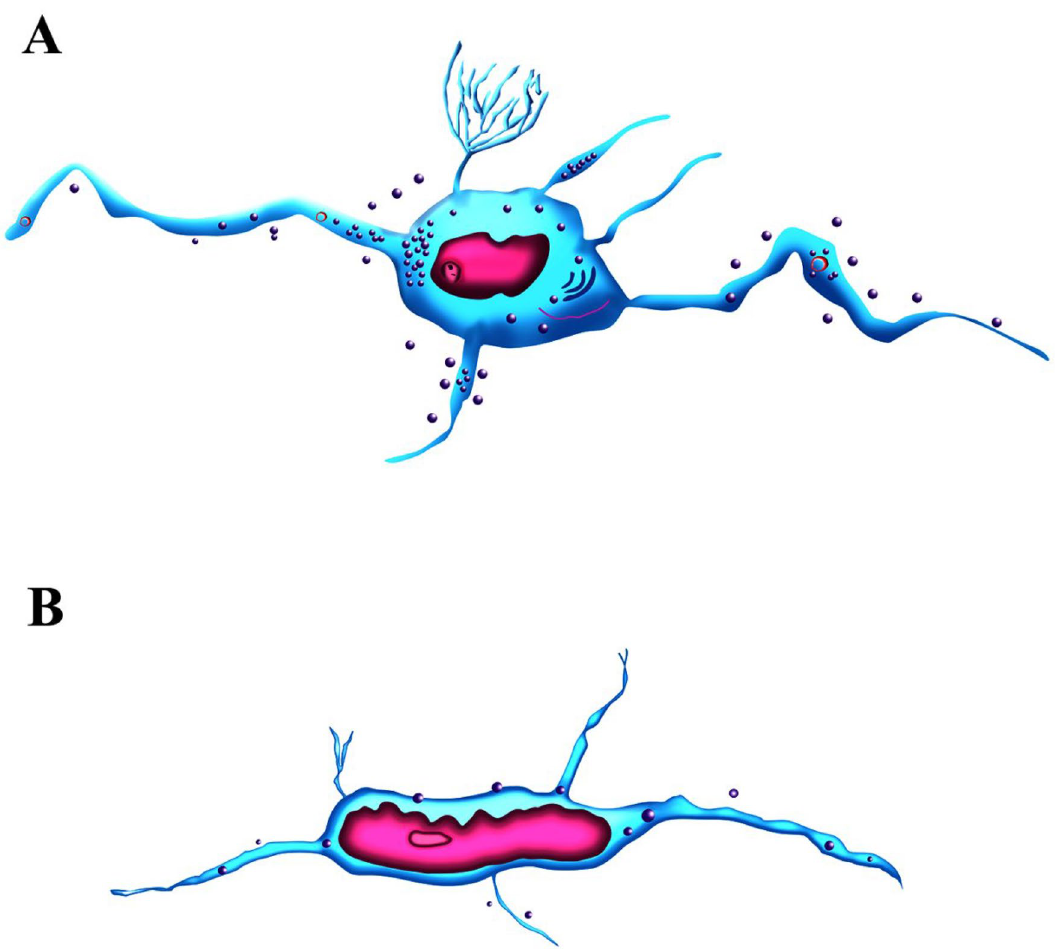
Figure 6. The morphology of TCs in the yak epididymis. ( A ) The TCs in the epididymis stroma. The round cell, obvious nucleolus, and slim and varied number of telopodes are the main characteristics of TCs. A large number of secretory vesicles, as well as mitochondria, and occasionally rough endoplasmic reticula are abundant in the cytoplasm. The exocytosis secretions are communicated by TPs. ( B ) The morphology of TCs close to the basal membrane of the epididymis tube. The small nucleus, irregularly long striped telopodes are the main feature of this type of TCs, but few secretory vesicles were distributed in the TPs. These cells may establish special connections with different cells of the epididymis